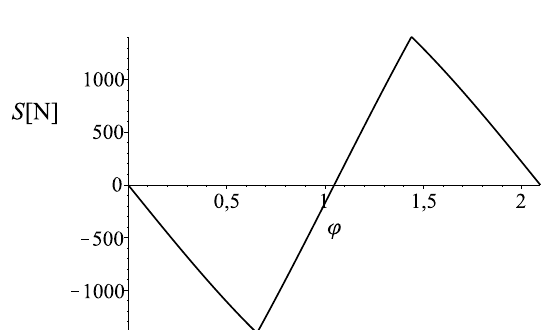
Figure 9: The plot of the shear force function.